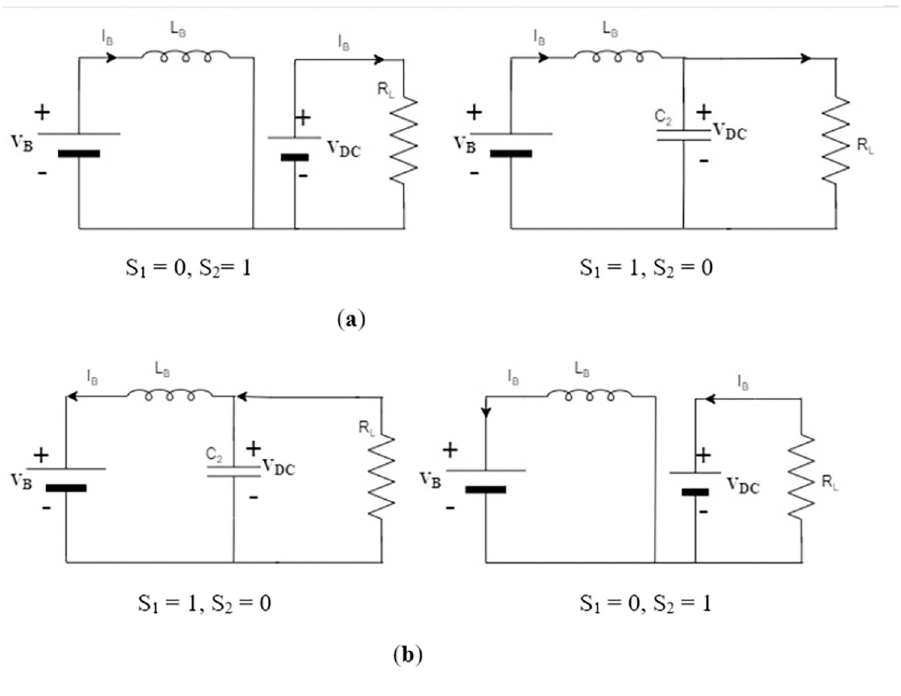
Fig 6. Topologies of bidirectional DC/DC converter (buck-boost) for BESS. ( a ) Boost Mode; ( b ) buck Mode.